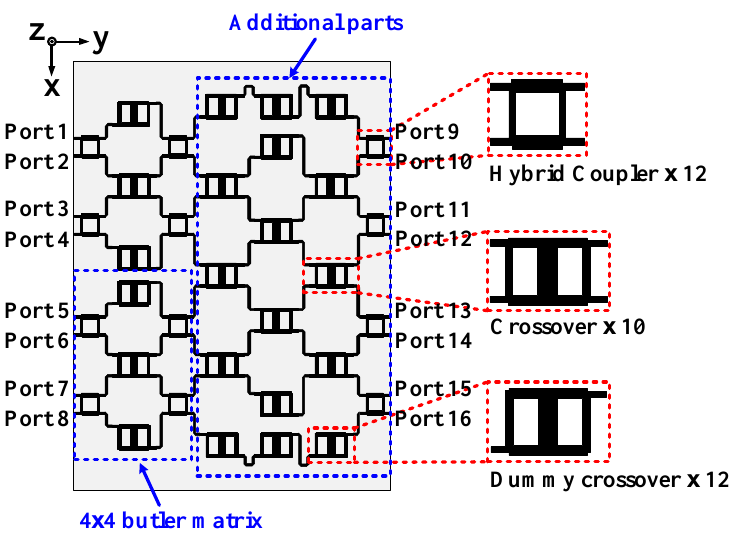
Figure 3. Structure of the 8 × 8 Butler matrix. Table 1. Phases associated with the selected port of the 8 × 8 Butler matrix.